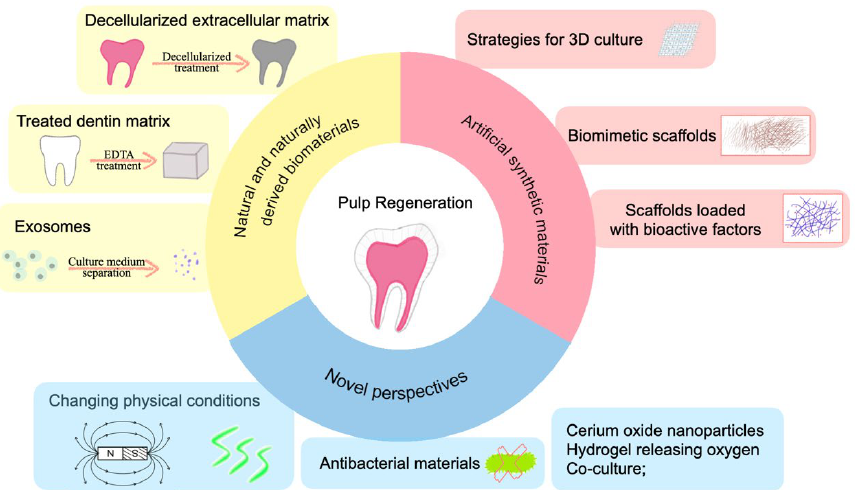
Figure 2. Summary of strategies for creating a microenvironment for dental pulp regeneration.